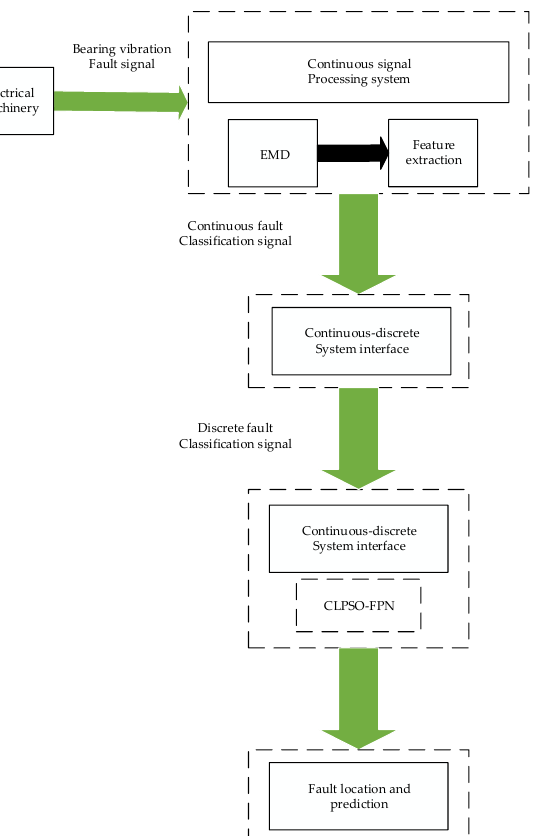
Figure 1. The structure diagram for fault-diagnosis system of CLPSO-FPN. The continuous signal processing system in Figure 1 applied continuous signal pro- and transmitted the obtained discrete fault classification signals to the discrete signal pro-